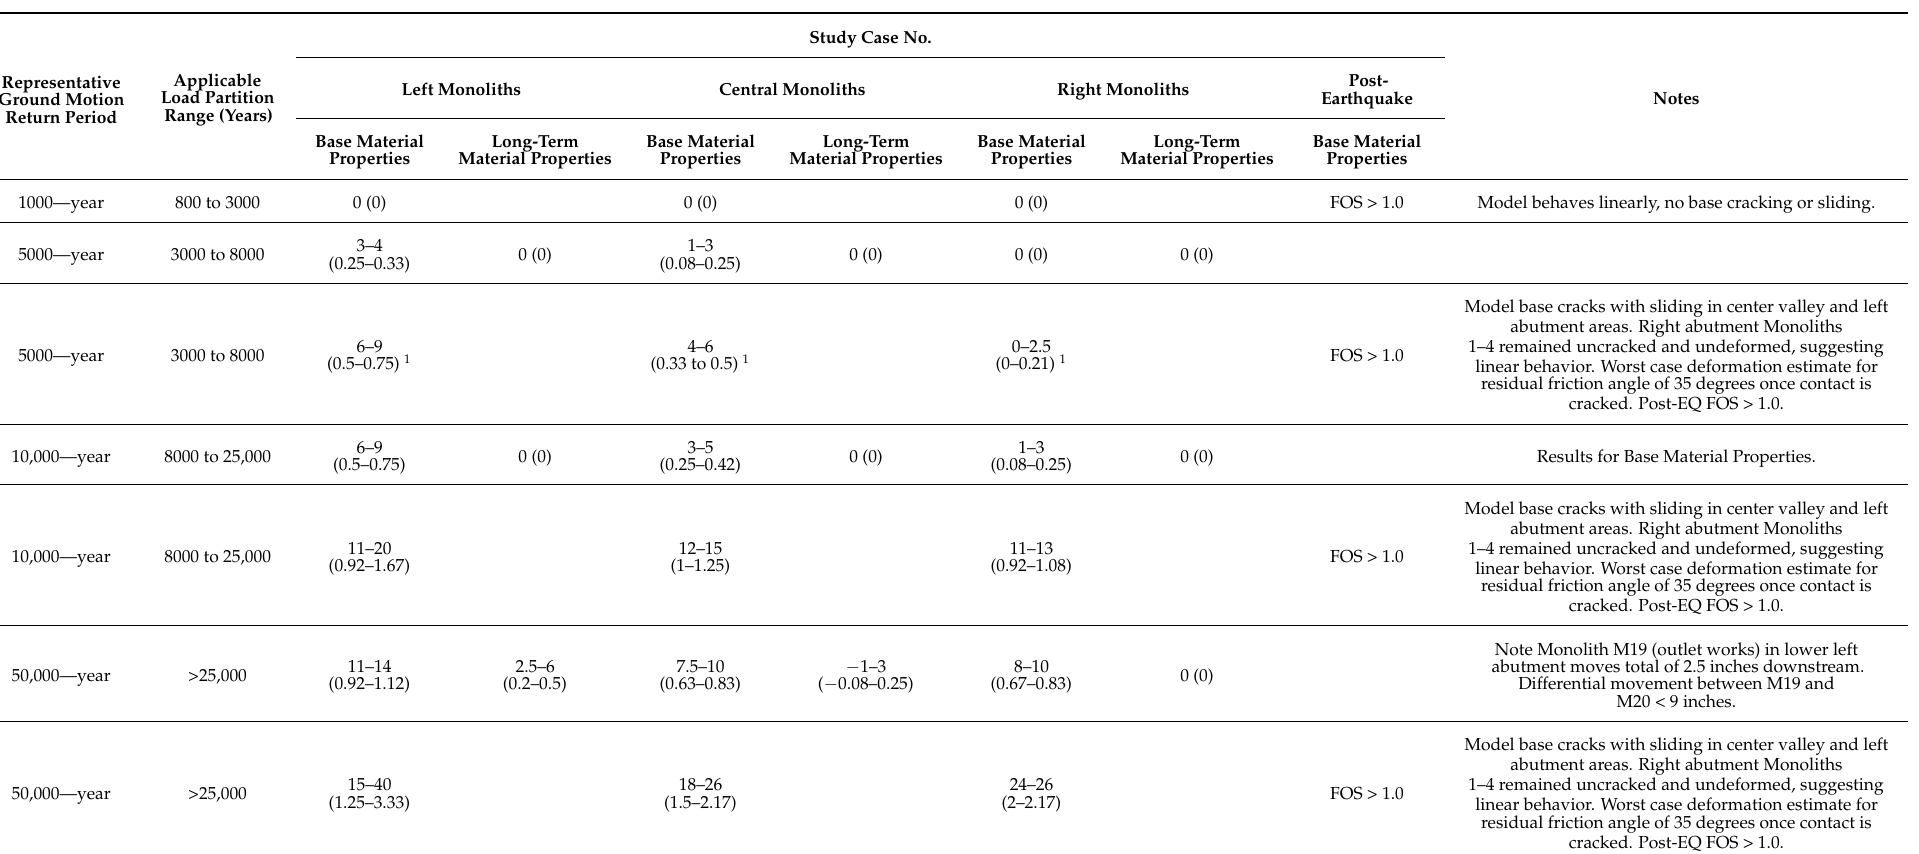
Table A3. Summary of study case results for risk analysis—Columns 3 through 8 show estimated monolith downstream deformations in inches (feet)—MYG008 (short duration local/interslab ground motion). Column 2 shows the seismic load partition range used in the Risk Analysis for which the representative ground motion return period (shown in Column 1) was used to assess the performance of the